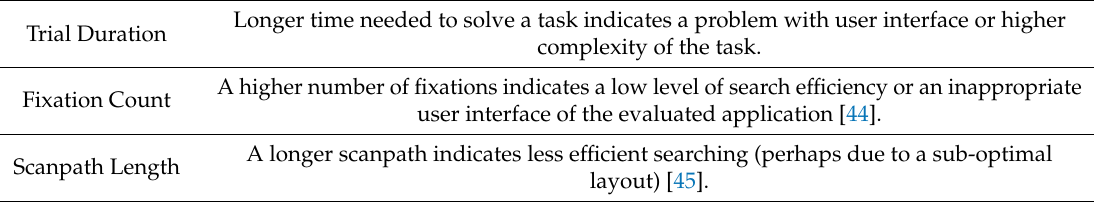
Table 1. Description of the eye-tracking metrics used and their meanings. Trial